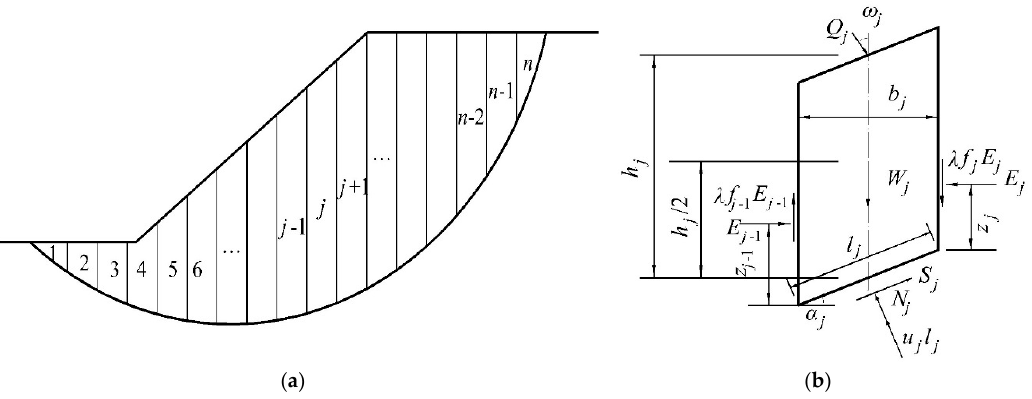
Figure 4. Discrete model and inter-slice forces in the slip surface of an unsaturated-soil slope ( a ) discrete model of a slip surface, ( b ) inter-slice forces.